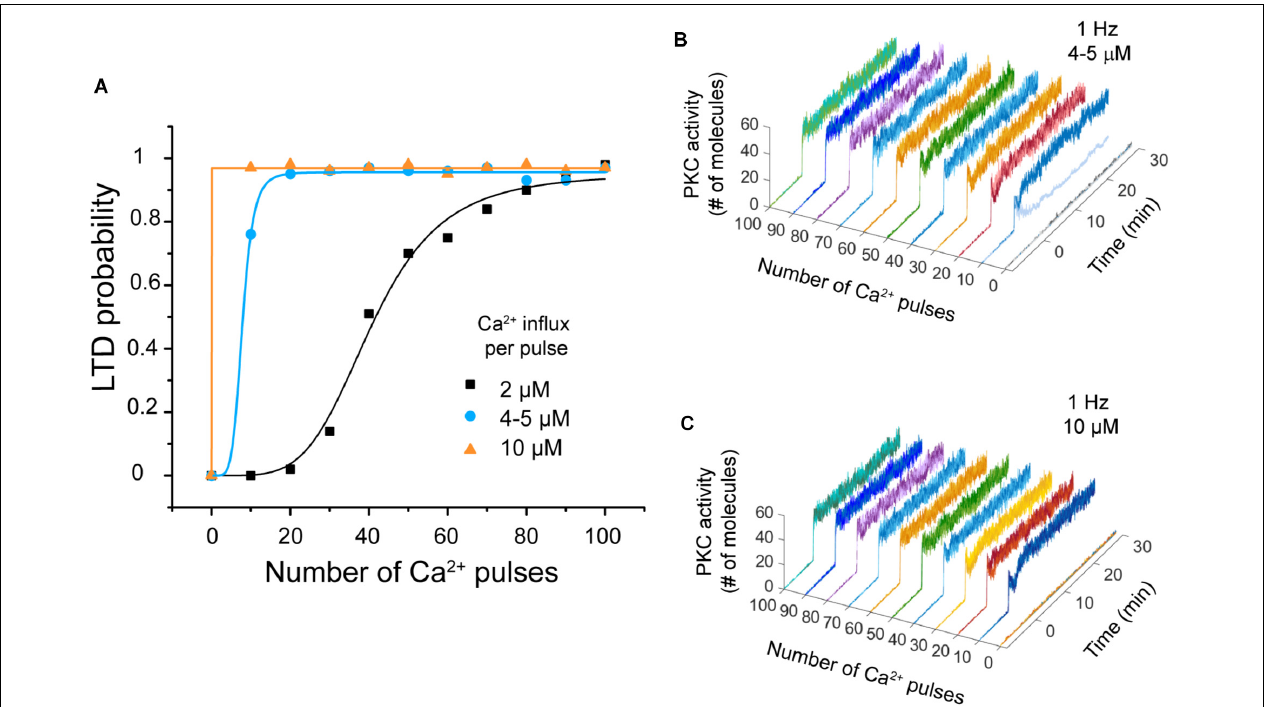
FIGURE 6 | LTD probability as a function of calcium influx amplitude. (A) Relationship between number of Ca 2 + pulses and LTD for different amplitudes of calcium influx per pulse at 1 Hz, 2 µ M (black), 4–5 µ M (blue), and 10–11 µ M (orange). Every symbol (square, circle, or triangle) represents the probability to get LTD state at specific number of Ca 2 + pulses and frequency over 100 trials. (B) PKC activity over time as a function of number of calcium pulses with an increment of amplitude to 4–5 µ M. Bistability is only present at 10 pulses. ( C ) PKC activity as a function of number of calcium pulses with an increment of amplitude to 10 µ M. PKC activity is always stable.